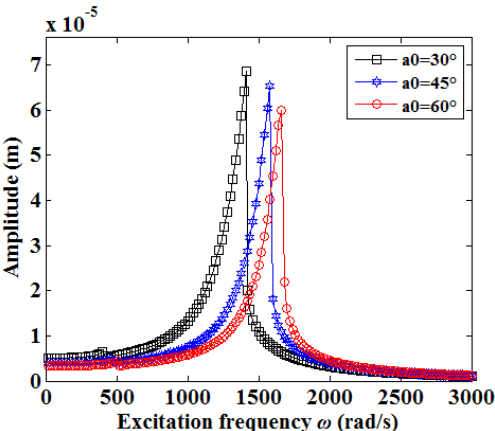
Figure 14. Amplitude-frequency curves of the feed system for different initial contact angles.